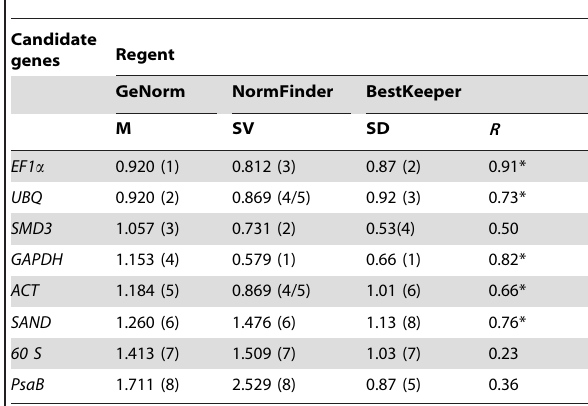
Table 3. Candidate reference genes for Biotic Stress effect in